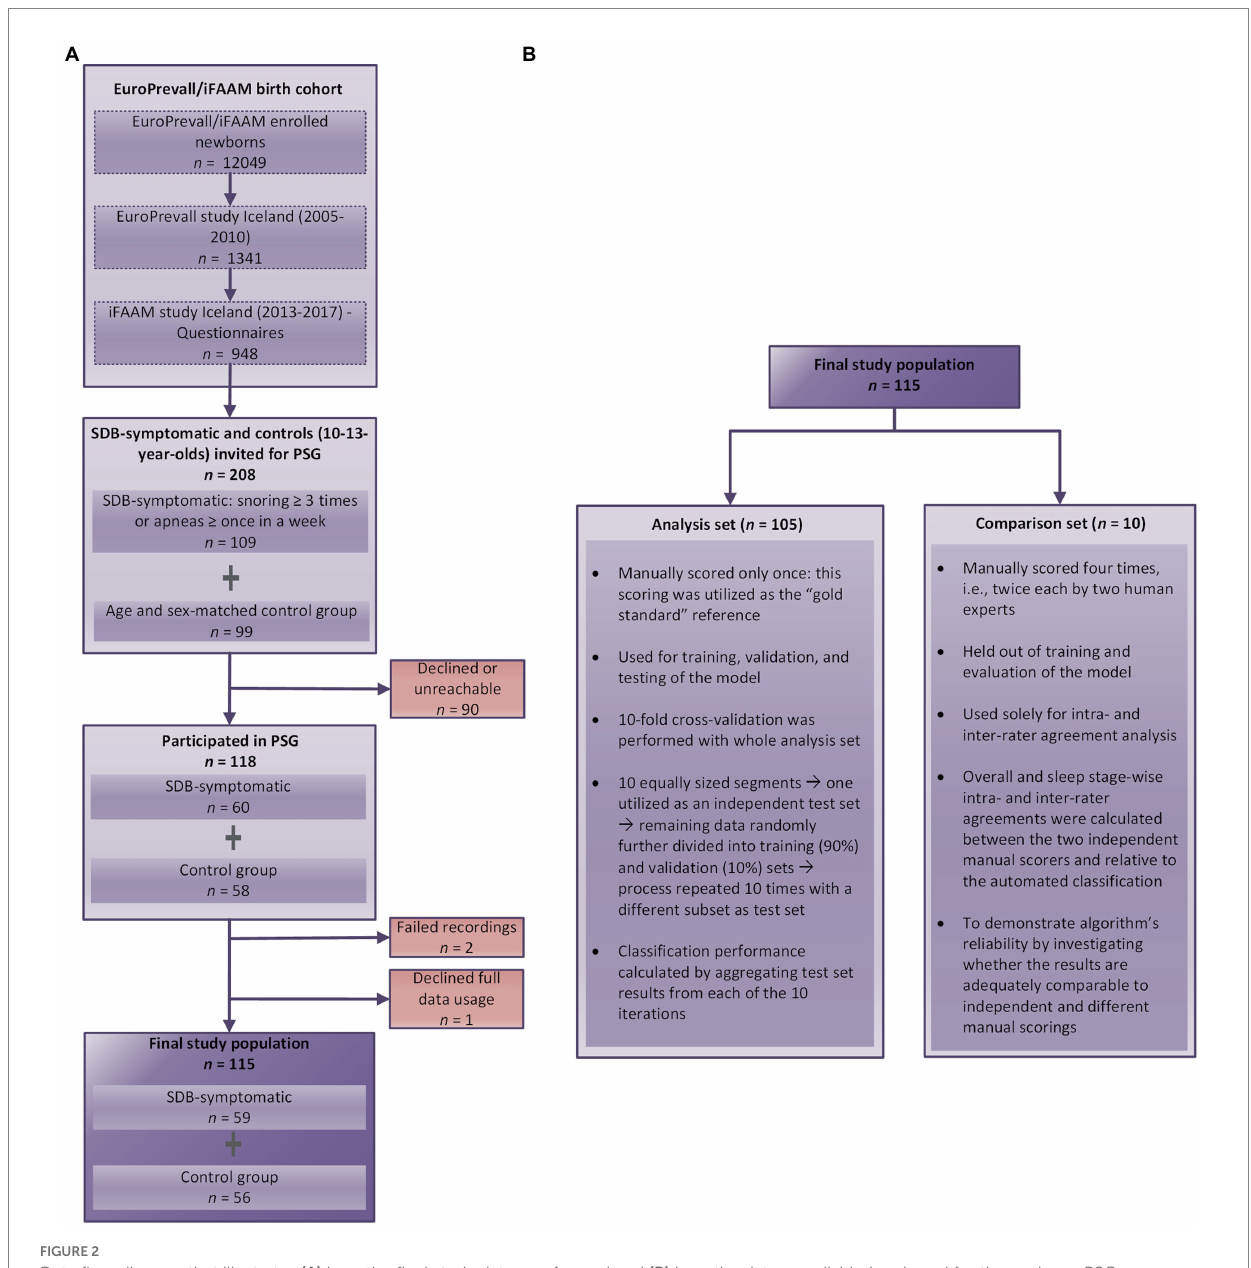
FIGURE 2 Data flow diagram that illustrates (A) how the final study data was formed and (B) how the data was divided and used for the analyses. PSG, polysomnography; EEG,